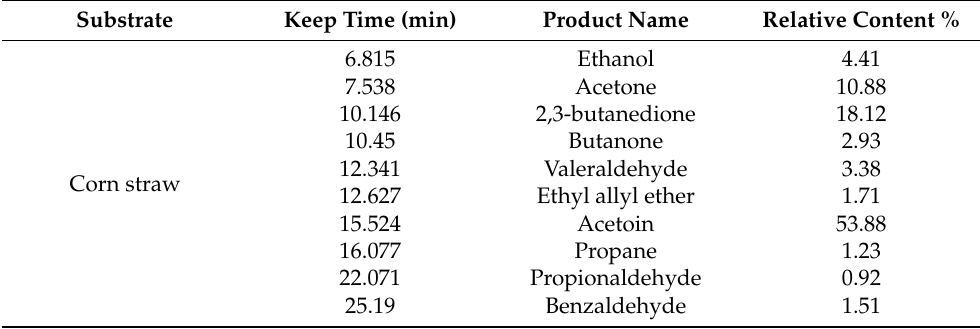
Table 2. Metabolites of Rummeliibacillus sp. TYF-LIM-RU47 GC-MS analysis results.